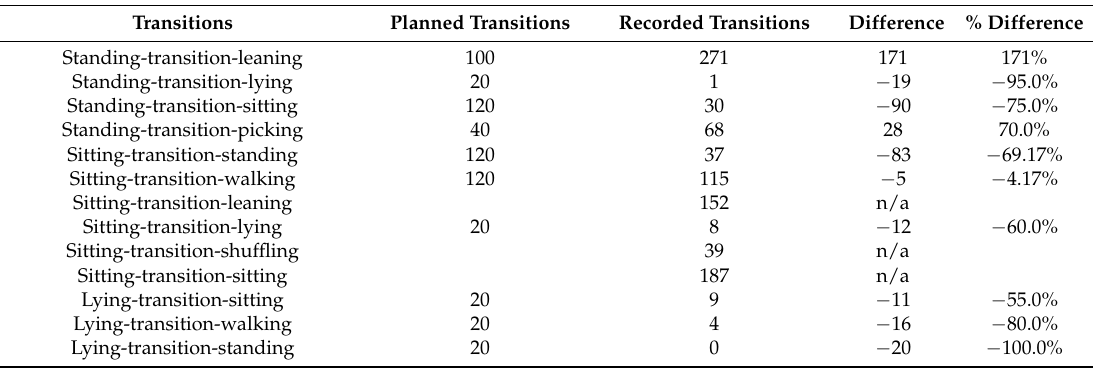
Table 11. Activity-Transition-Activity